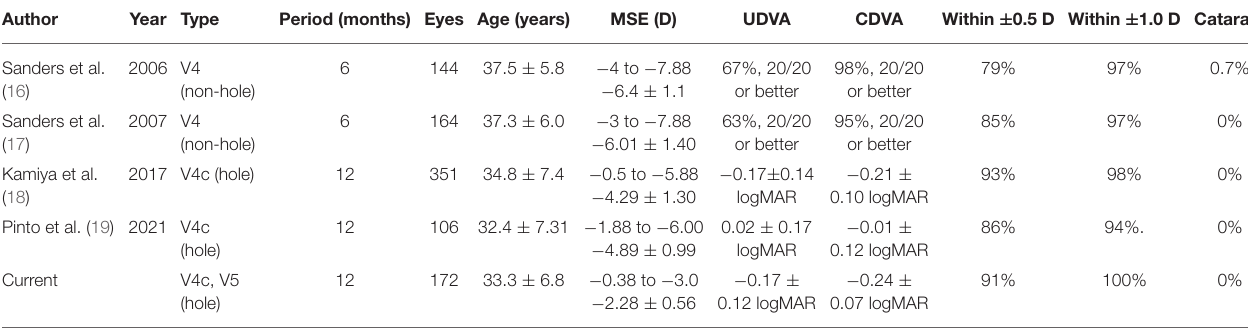
TABLE 2 | Summary for the outcomes of ICL implantation for low-to-moderate myopia.